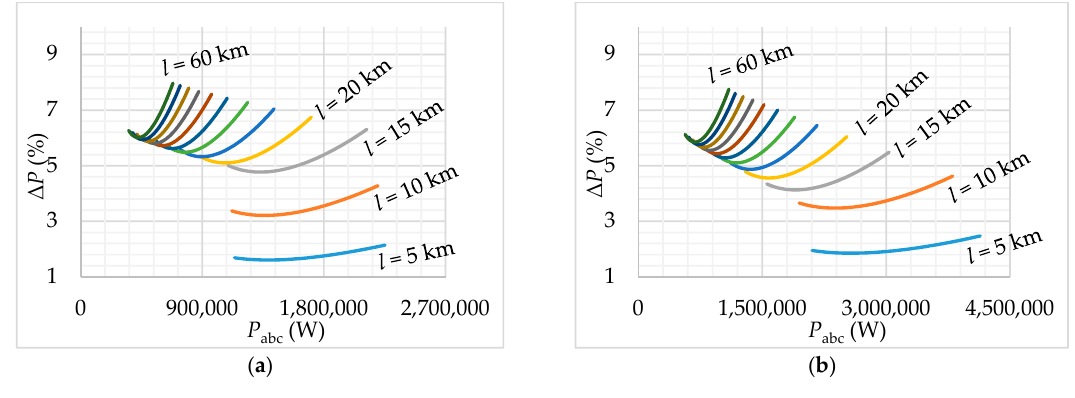
Figure 10. Scenario 4: ( a ) ACSR 42/7; ( b ) ACSR 70/11. Energies 2019 , 12 , x FOR PEER REVIEW